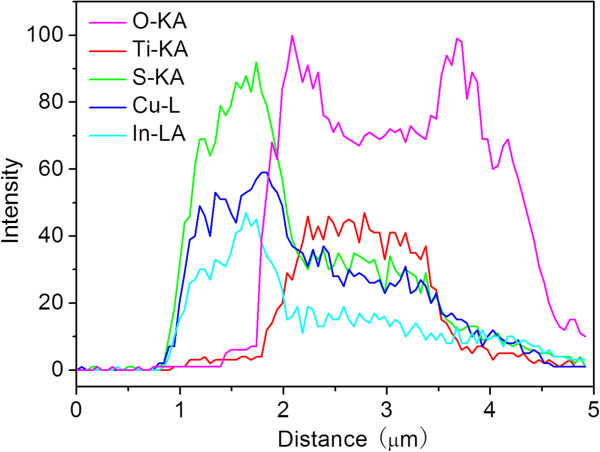
EDS line scan analysis along the red line indicated in the SEM image (Figure5b).